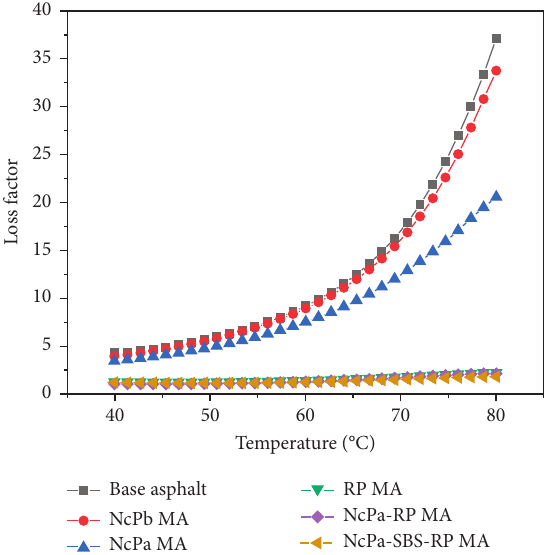
Figure 8: Loss factor versus temperature.